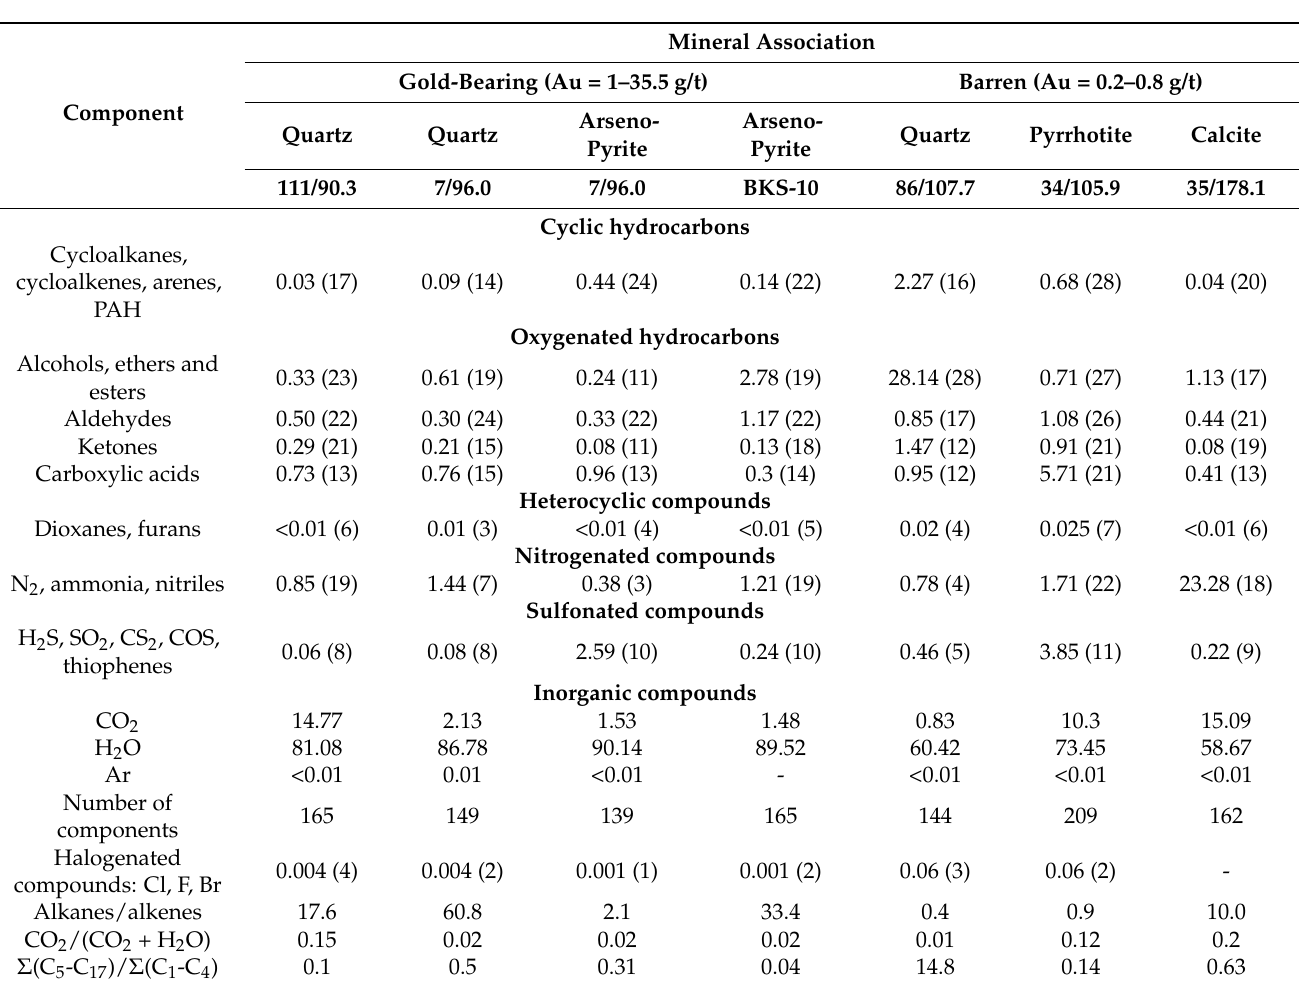
the areas of individual chromatographic peaks to the total area of all peaks.